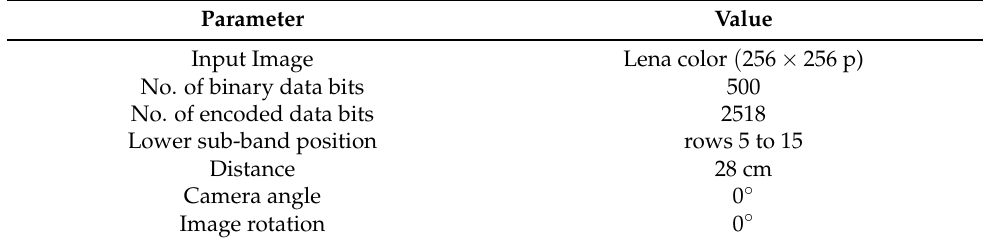
Table 3. Experimental parameters for noise